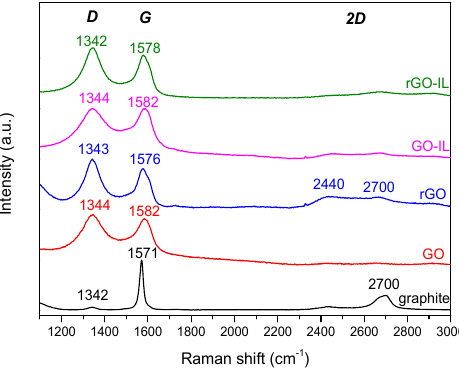
Figure 5. Raman spectra of graphite, GO, rGO, GO-IL, and rGO-IL. Table 4. Raman shifts of the D band, G band, and 2D band for graphite, GO, rGO, GO-IL, and rGO- IL.